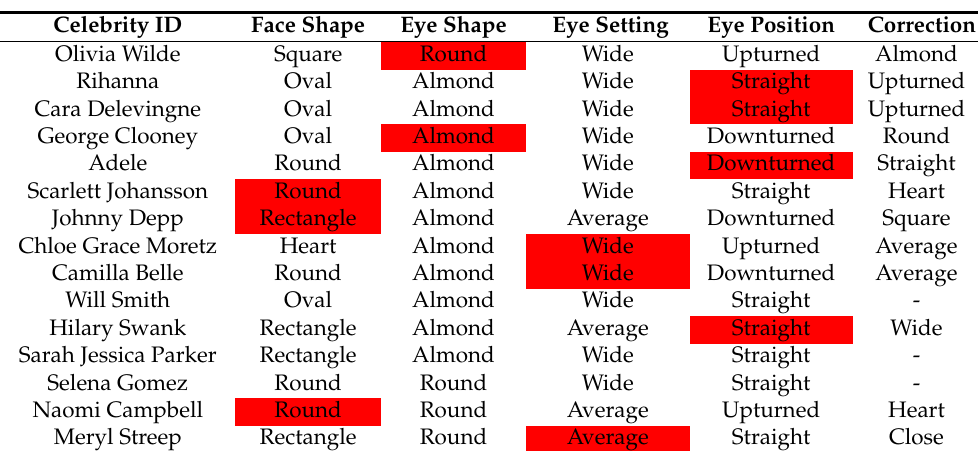
Table 7. Performance evaluation of proposed system on external image data. Red cells refer to incorrect detection while last column shows the true